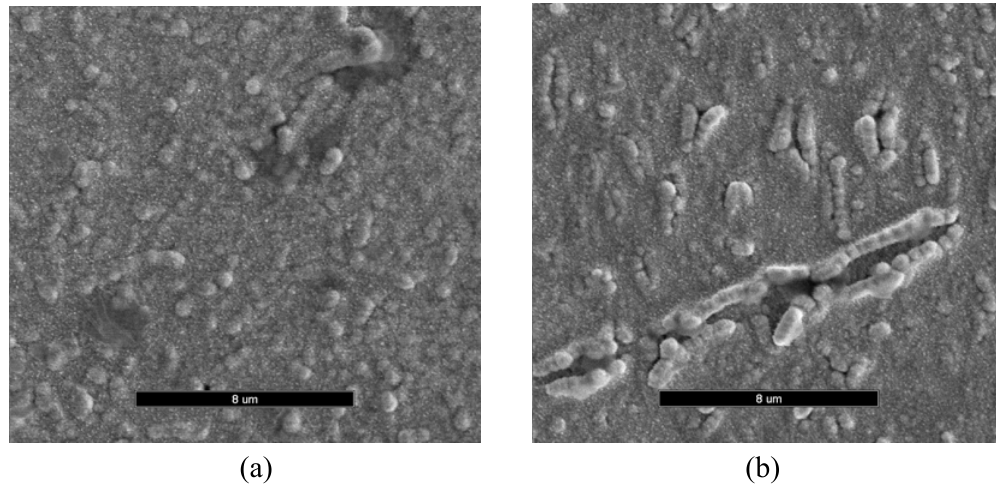
Figure 3. Scanning electron micrographs obtained for PTy films in the (a) absence and (b) presence of PNCnase (37 U/mL). Monomer solution contained 0.03 M tyramine, 0.003 . Electropolymerization conditions were: current density of M penicillin and 0.01 M KNO 3 0.9 mA/cm 2 and polymerization time of 5 minutes. Magnification was x5,000 in both cases.